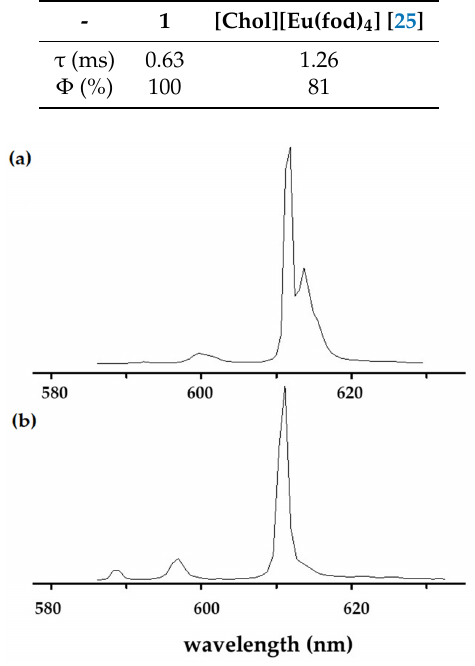
Table 1. Emission lifetime ( τ , ms) and absolute emission quantum yield ( Φ , %) of 1 and [Chol][Eu(fod) 4 ].